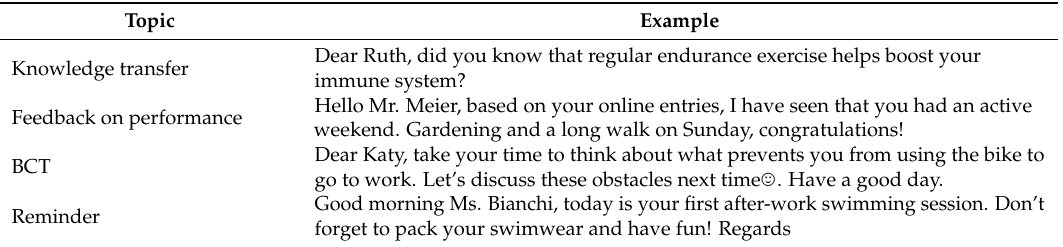
Table 3. Example for text